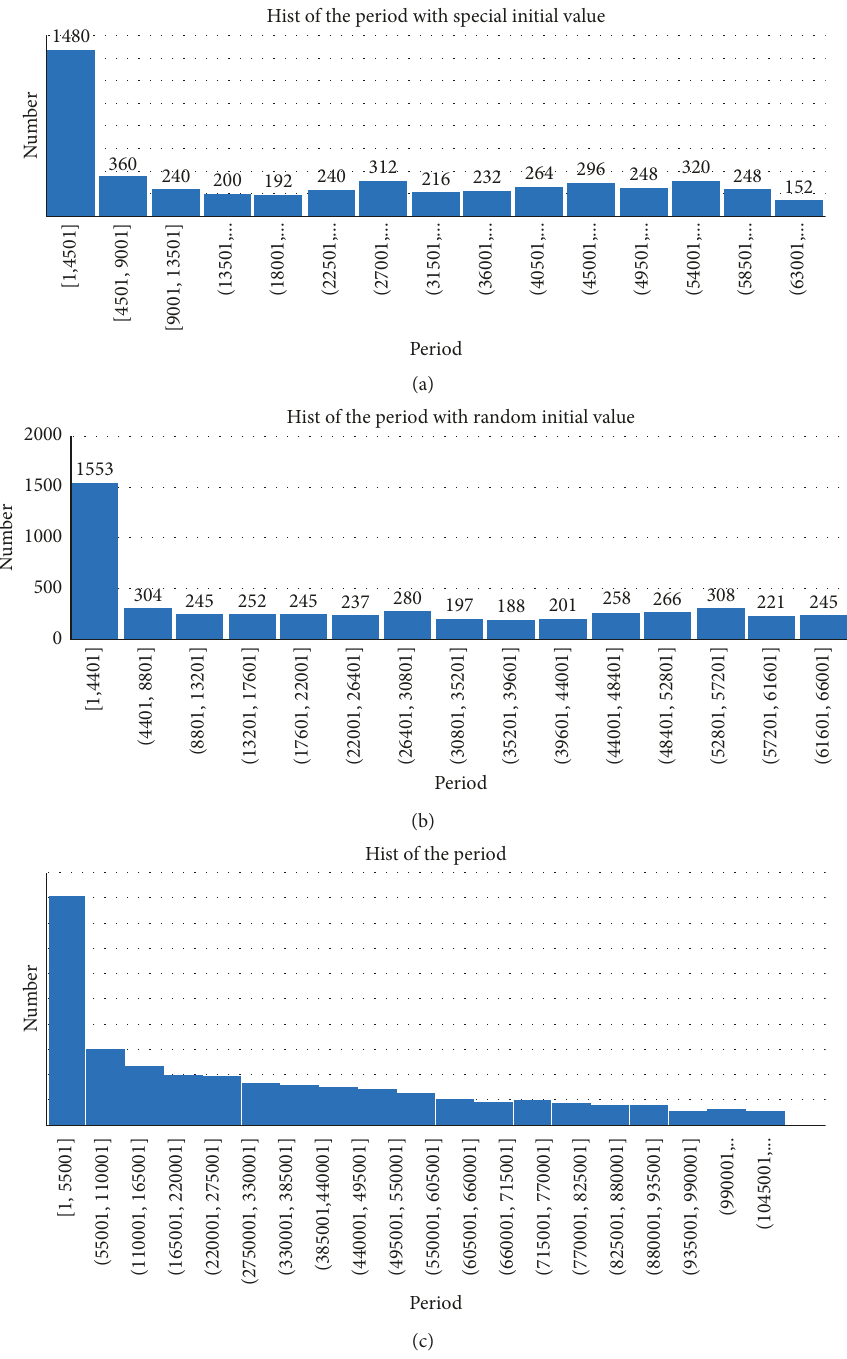
Figure 7: Hist of LMFSR period: (a) with special initial value of the LMFSR with 4 feedback shift registers, (b) with random initial value of the LMFSR with 4 feedback shift register, and (c) with 5 feedback shift